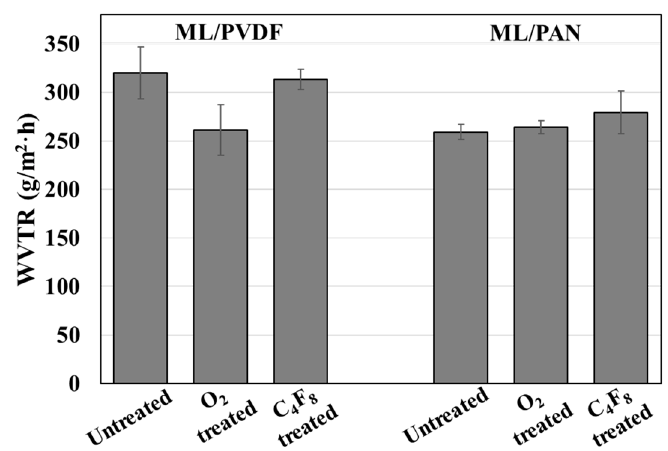
Figure 9. E ff ect of hydrophobic and hydrophilic treatment for ML / PVDF and ML / PAN composite Figure 9. Effect of hydrophobic and hydrophilic treatment for ML/PVDF and ML/PAN fabrics on water vapor transmission rate composite fabrics on water vapor transmission rate (WVTR).